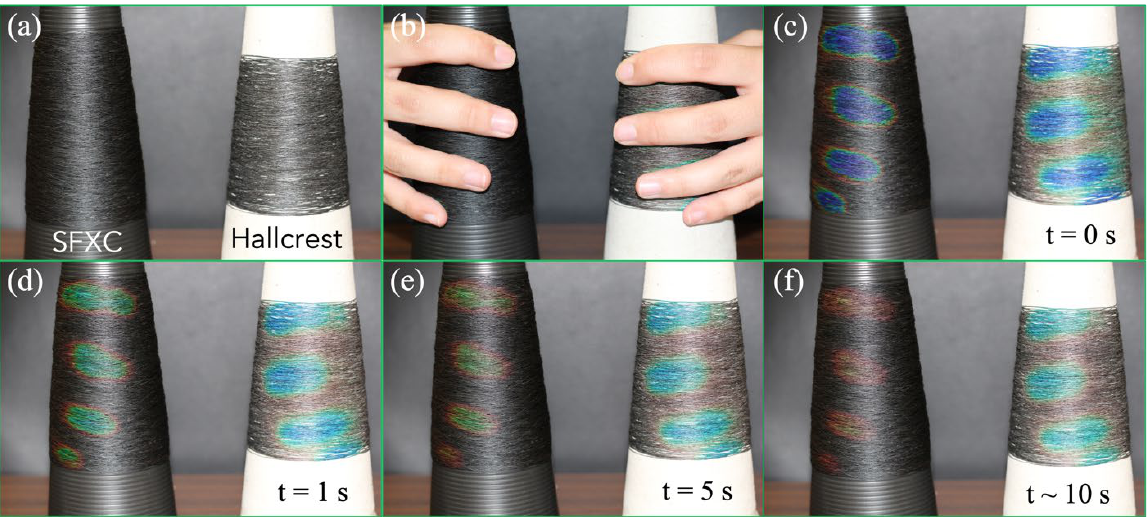
Figure 3. Spool of continuous SFXC and Hallcrest LC coated yarns showing the temperature re- sponse at different stages: ( a ) Before hands were placed on the spools. ( b ) Hands on the spools. ( c ) Immediately after the hands were removed (t = 0). Color play at ( d ) t = 1 s, ( e ) t = 5 s, and ( f ) t ~ 10 s. After the weaving and knitting process the thermochromic properties are retained without significant decrease in the color density for SFXC coat. Figure 4 highlights the of SFXC coated polyester yarn at temperatures 27, 28 and 29 ◦ C to show the red, green, and blue color shifts,